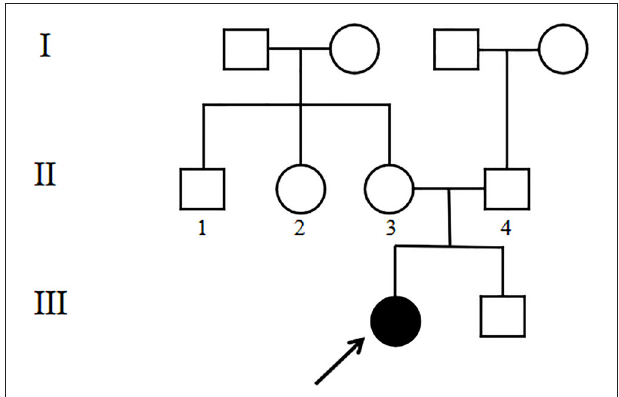
FIGURE 1 | Pedigree of the family with CS. The black arrow denotes the